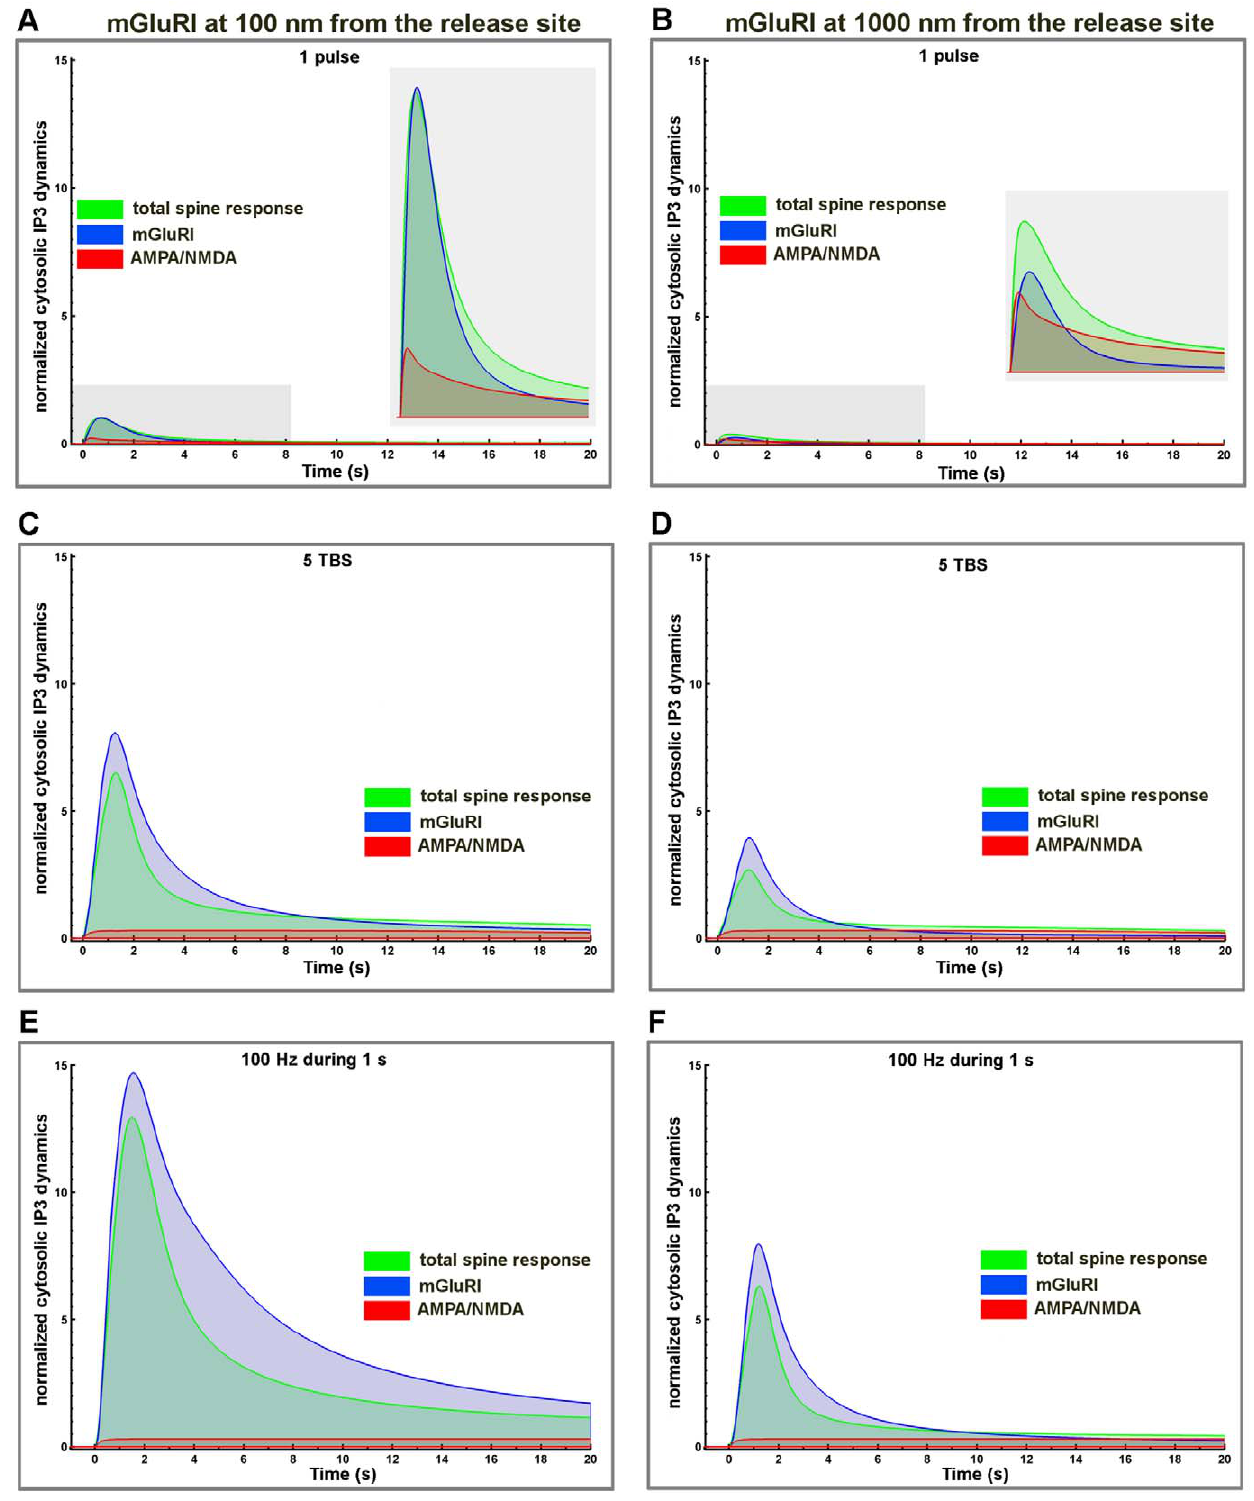
Figure 10. Respective contribution of ionotropic and metabotropic glutamate receptors on IP3 cytosolic dynamics for different stimulation patterns and mGluRI locations. Temporal evolution of cytosolic IP3 concentration (total response, green lines) generated by activation of ionotropic glutamate receptors (AMPA/NMDA, red lines) and mGluRI (blue lines) in response to one release event (A, B), 5 TBS (C,D) or 100 Hz during 1 s (E, F) with mGluRI located at 100 nm (A, C, E) or 1000 nm (B, D, F) from the release site. Values were normalized to the peak amplitude of the IP3 response produced by AMPA, NMDA and mGluRI receptors combined, following one release event with mGluRI located at 100 nm from the release site (315 nM).